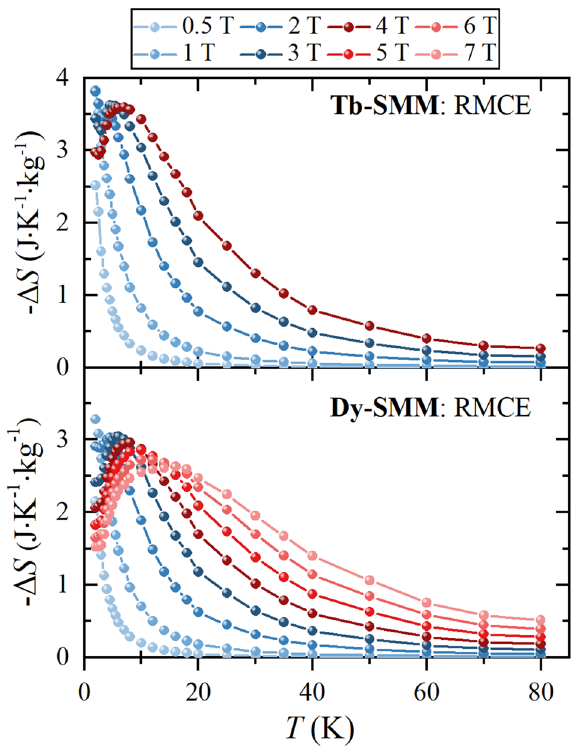
Figure 5. The RMCE entropy change − Δ S ( T , H ) as a function of the temperature T ranging from 2 to 80 K for the selected magnetic fields µ 0 H for Tb-SMM and Dy-SMM . Solid lines are guides for the